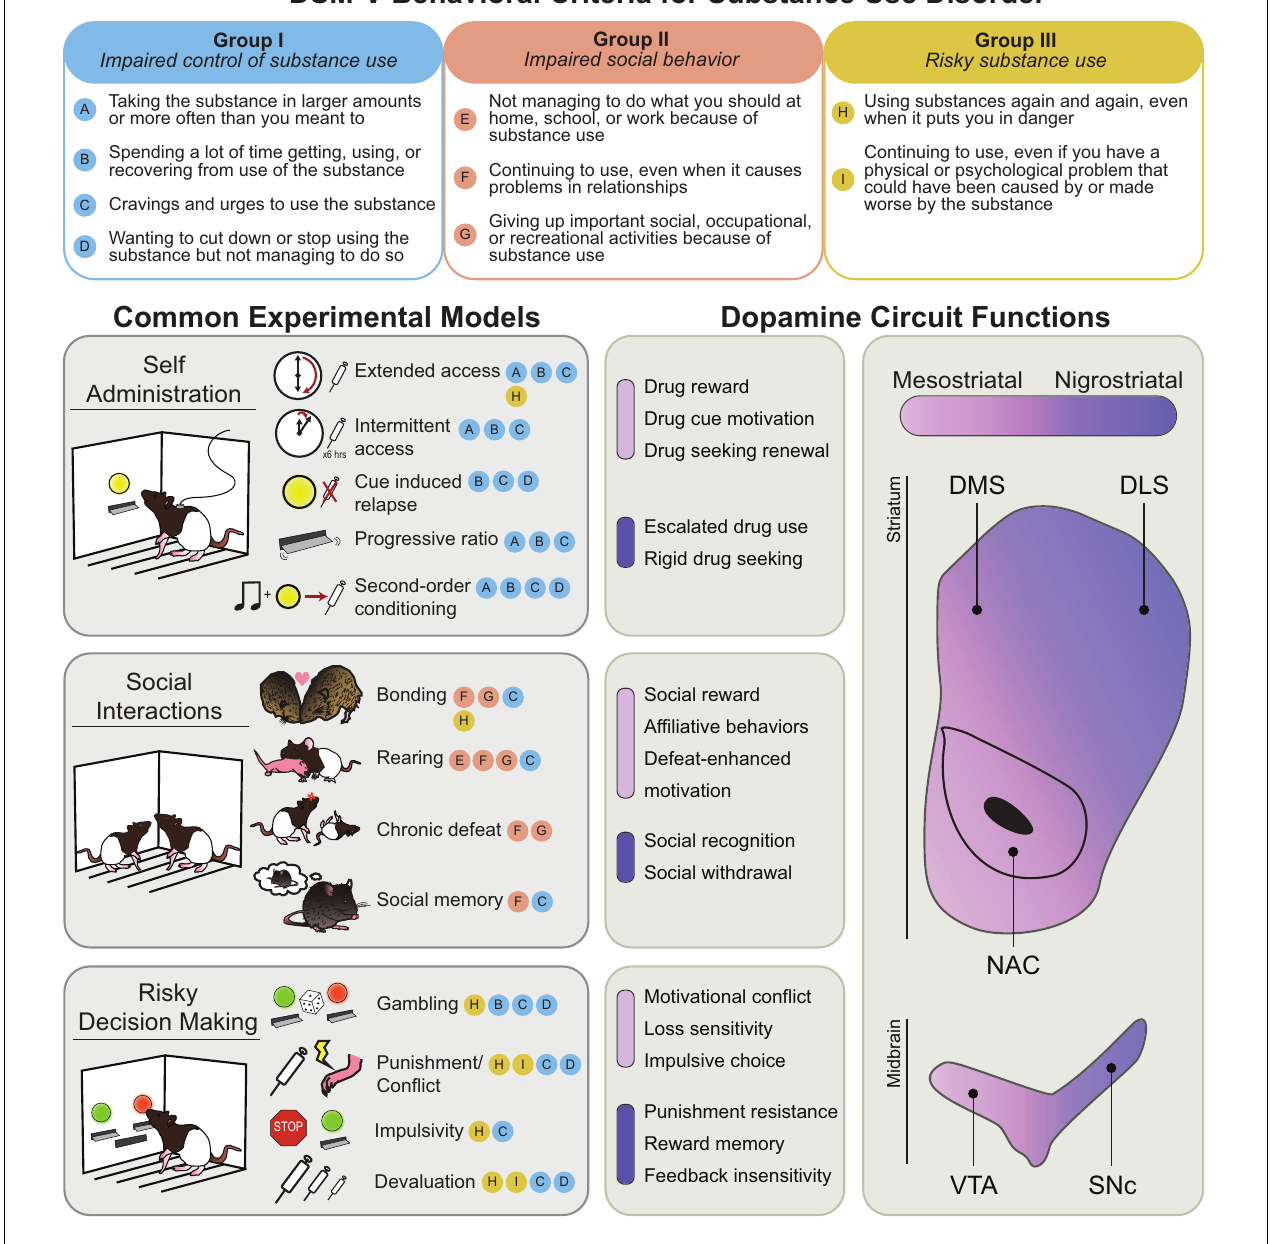
FIGURE 1 | Behavioral models used to classify phenotypes of substance use disorder. (Top) The behavioral criteria of SUDs (circled letters) can be sorted into three main categories: impaired control of substance use (Group I), impaired social behavior (Group II), and risky substance use (Group III). (Left) Common rodent experimental models and the SUD criteria they are thought to best approximate. Note that most models capture multiple SUD features. (Right) Mesostriatal circuits (light purple), including dopamine projections from the ventral tegmental area (VTA) to the nucleus accumbens (NAC), and nigrostriatal circuits (dark purple), including dopamine projections to the dorsomedial (DMS) and dorsolateral striatum (DLS), have generally dissociable roles in different components of major SUD models. In the middle panels, the most clearly defined roles for these two systems in each SUD category are